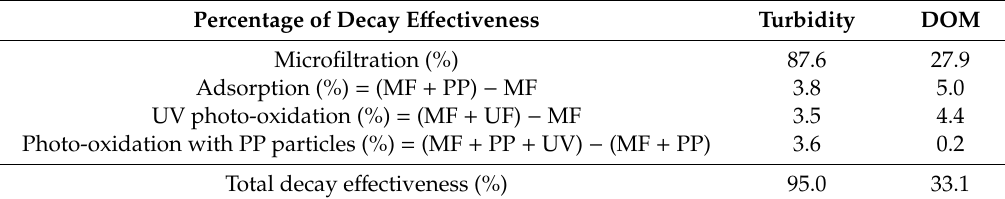
Table 5. Decay e ff ectiveness percentages of microfiltration, adsorption, and photo-oxidation in the integrated system, of multichannel ceramic MF and pure PP particles, using air backwashing at 6 mg / L of humic